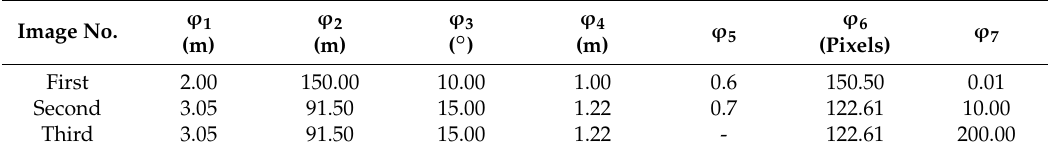
Table 2. Values of the seven parameters of our proposed method for the three test images. Image No.